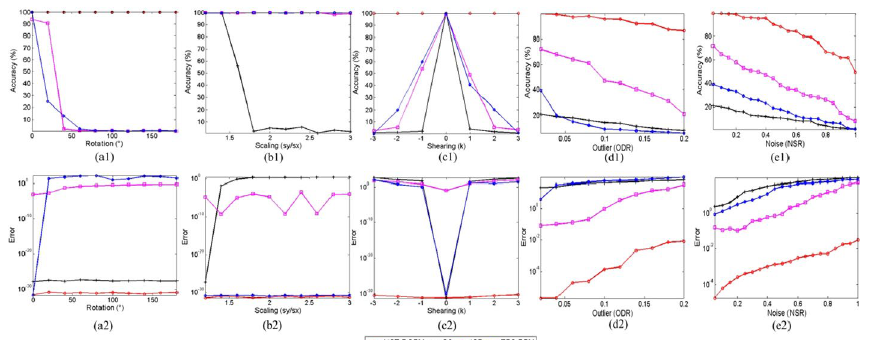
Fig. 5 Performance of algorithms for point matching with respect to rotation (first column), scaling (second column), shearing (third column), outliers (fourth column) and noise (last column). The point matching accuracy and error are shown in the first row ( a1 – e1 ) and the bottom row ( a2 – e2 ), respectively